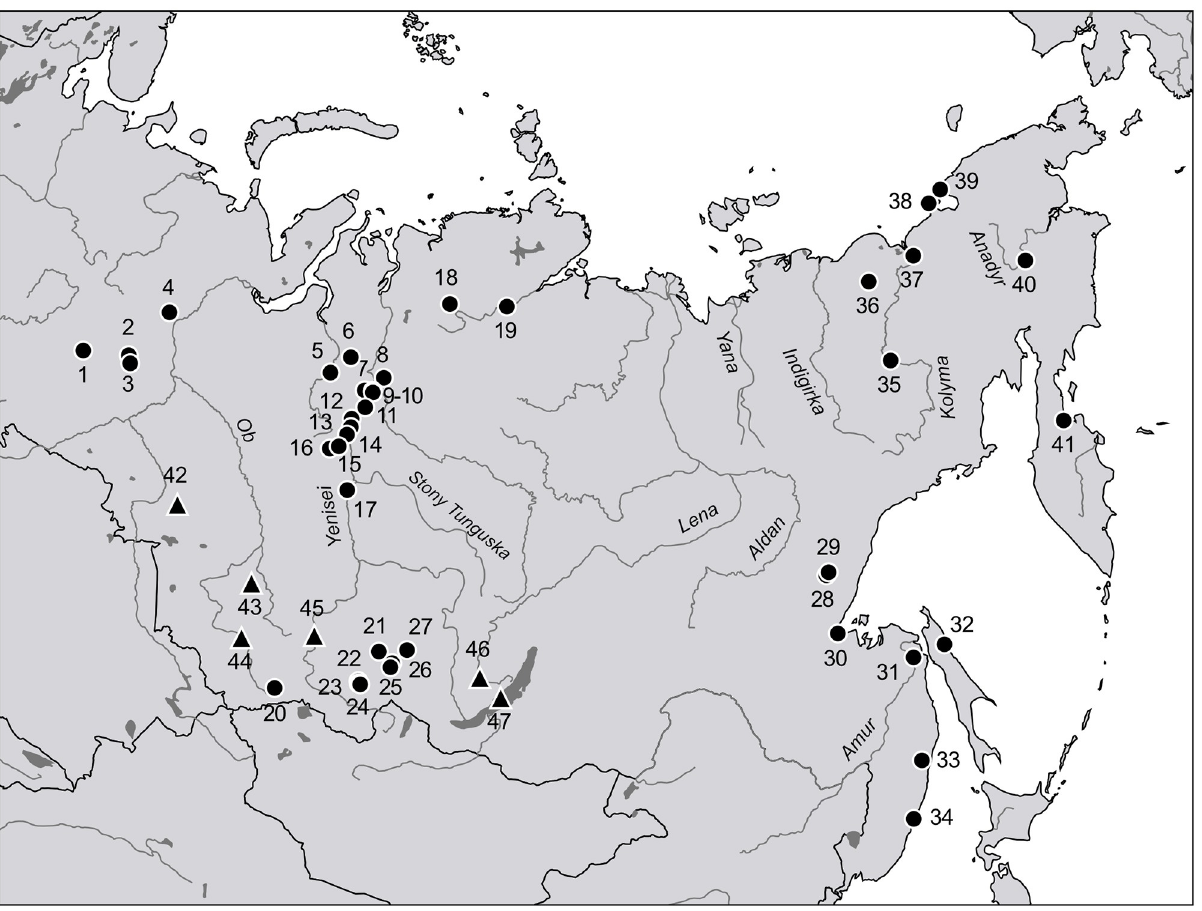
Fig 1. Map of Siberia. Black circles mark the settlements of sampling expeditions listed in S1 Table in S1 File: 1—v. Verkhoturye; 2—v. Shaim; 3—v. Urai; 4—v. Aneyeva; 5—v. Krasnoselkup; 6—v. Sovetskaya Rechka; 7—v. Farkovo; 8—v. Maduika; 9—v. Selivanikha; 10—v. Turukhansk;